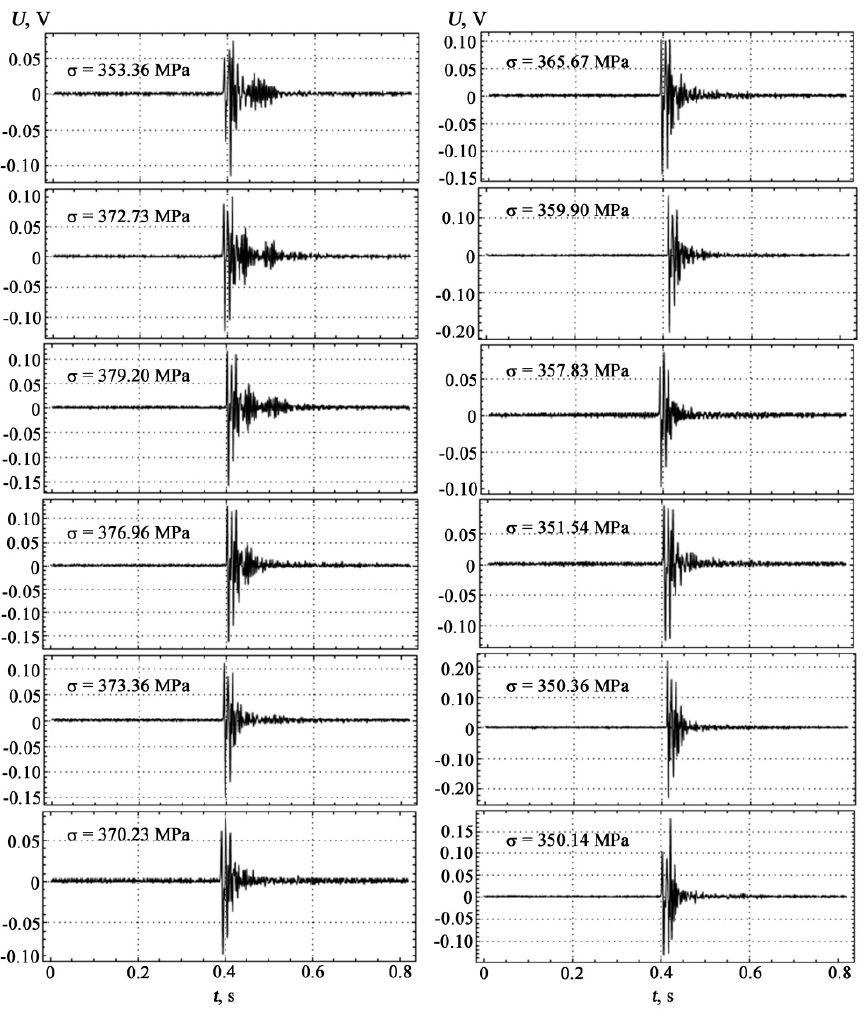
Figure 6. Visualization of measurement results of coated samples at different loads.